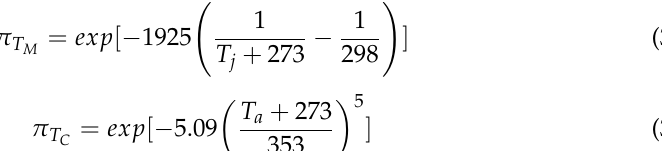
Table 3. Effective Factors on Components Failure Rates.